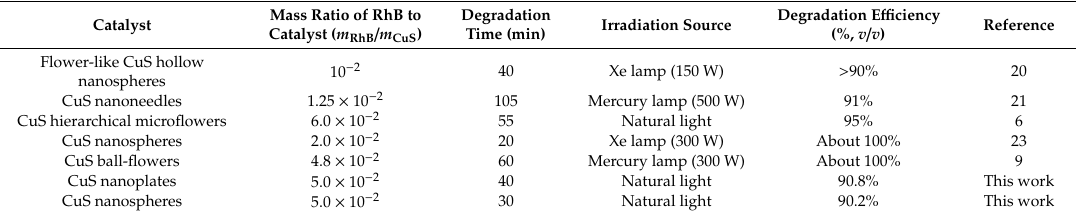
Table 1. Comparison of the photocatalytic performance of CuS nanoparticles prepared by this work with reported CuS